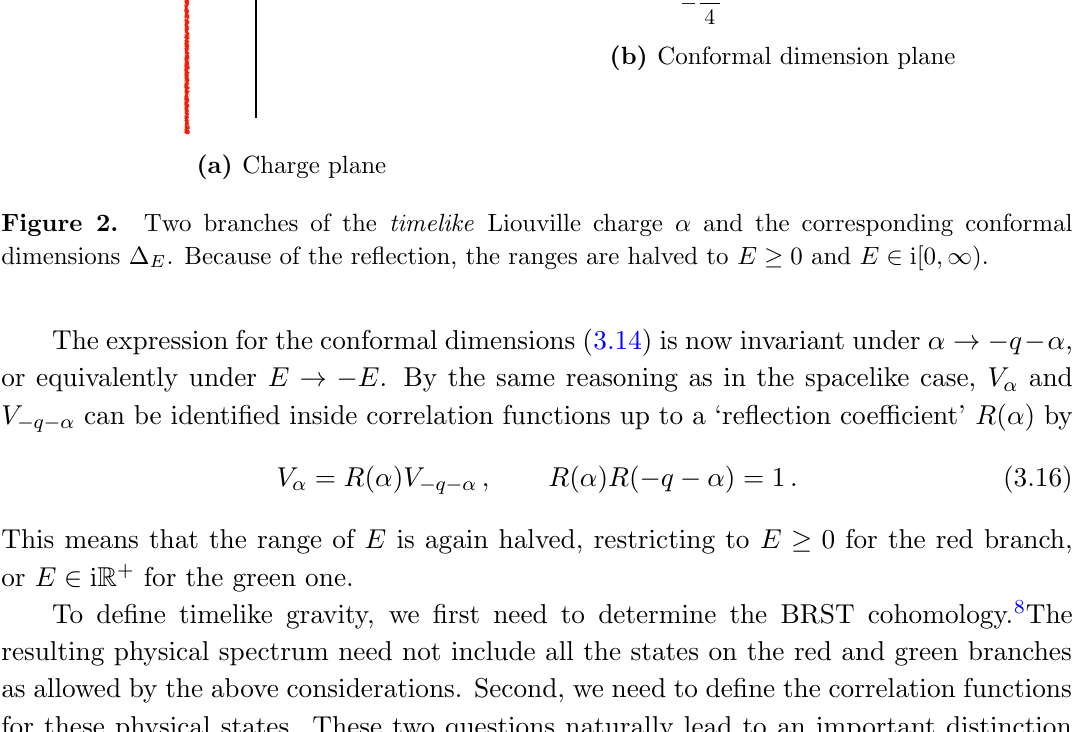
(b) Conformal dimension plane